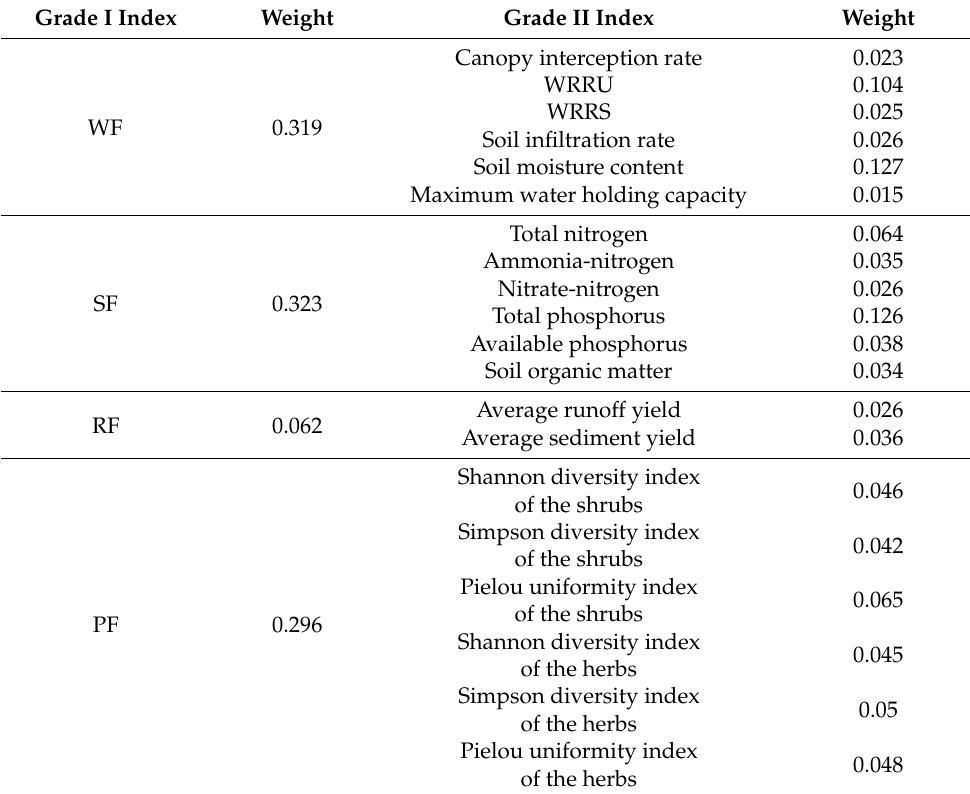
Table 2. The weighted values of the EFFIs of the Pinus tabuliformis